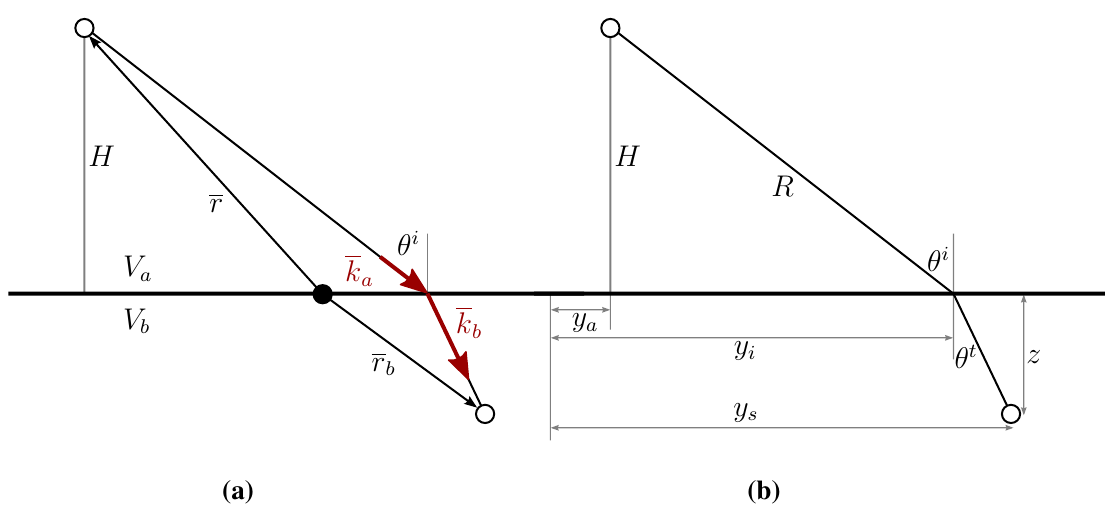
Figure 1. Description of the geometric setup: the circle at in the soil (halfspace V illuminated by the antenna at height H in V